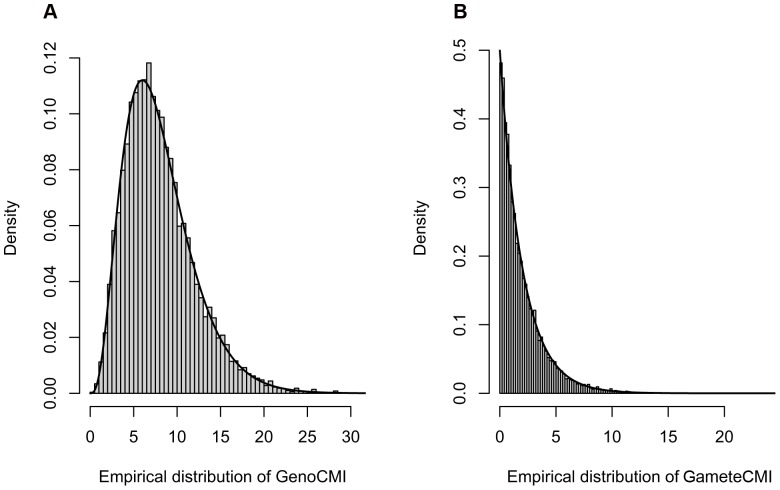
Null distribution of the GenoCMI and GameteCMI metrics.
A. The empirically null distribution of GenoCMI, compared to its theoretical distribution χ
2
(8). B. The empirically null distribution of GameteCMI, compared to its theoretical distribution χ
2
(2).